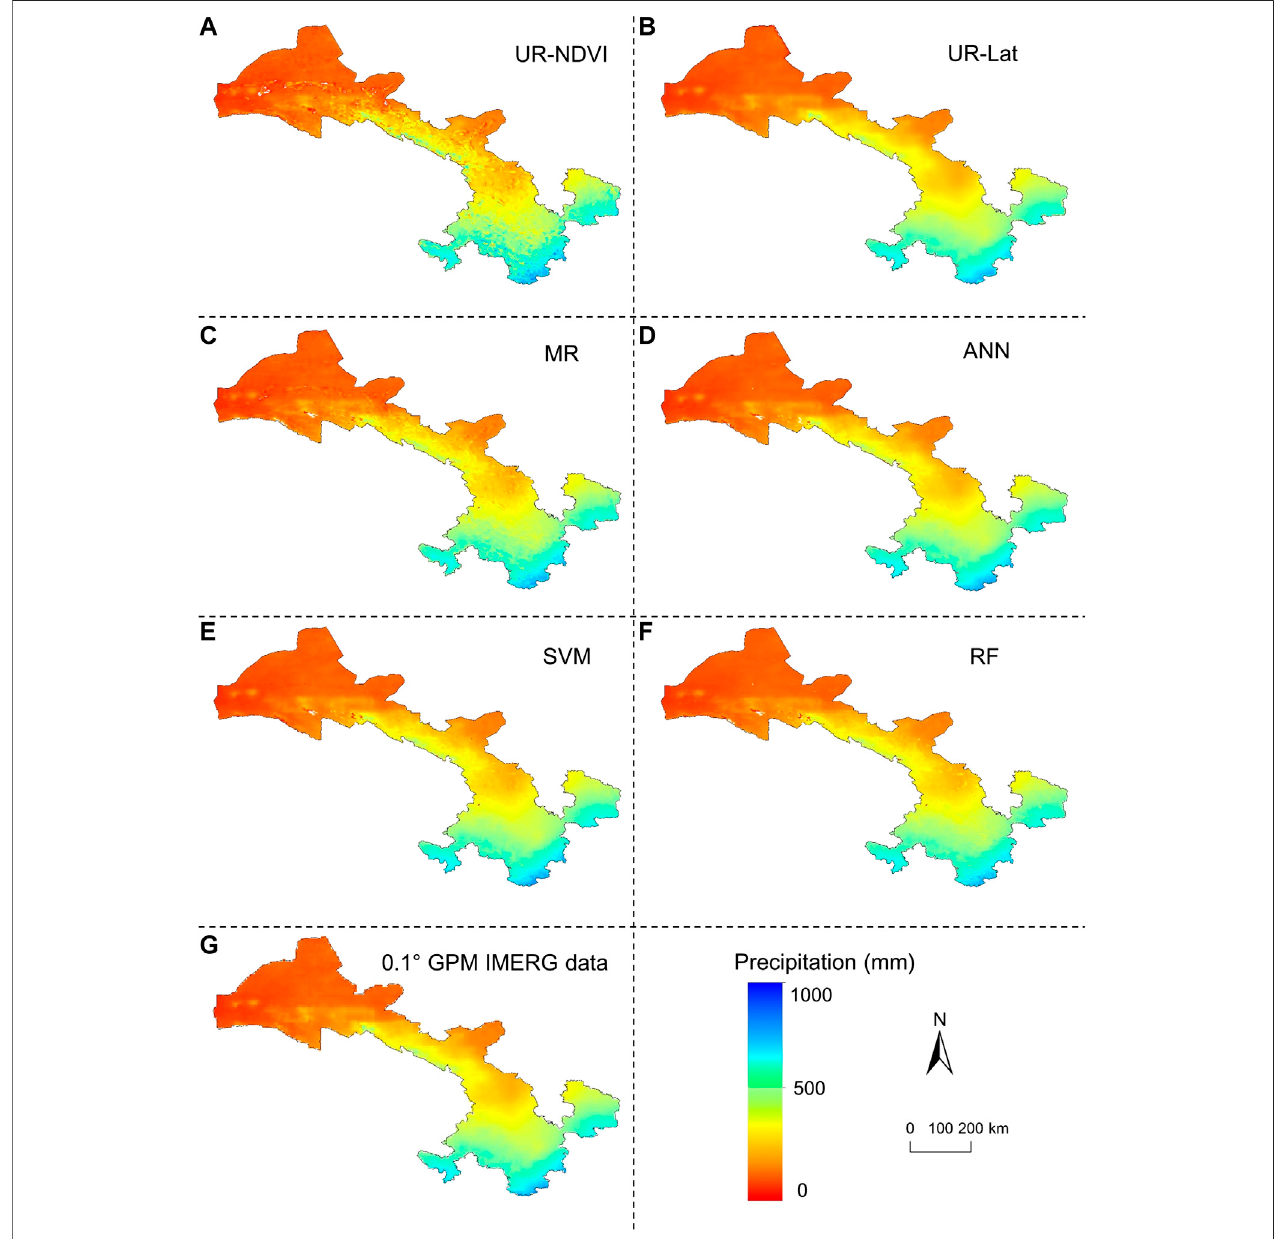
FIGURE 7 | (A – F) Downscaled 1 km IMERG precipitation after residual correction in 2015 by UR-NDVI, UR-Lat, MR, ANN, SVM, and RF; (G) original 10 km GPM IMERG data in 2015.